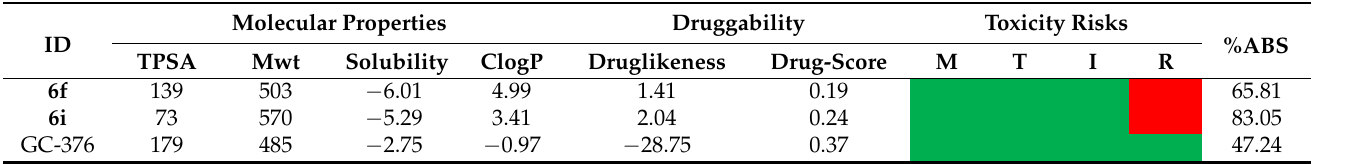
Table 3. Toxicity risks and physicochemical properties of compounds 6f and 6i in comparison with reported drugs, predicted by OSIRIS Property